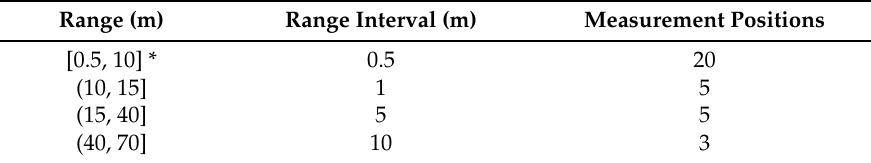
Table 1. Range sample design.